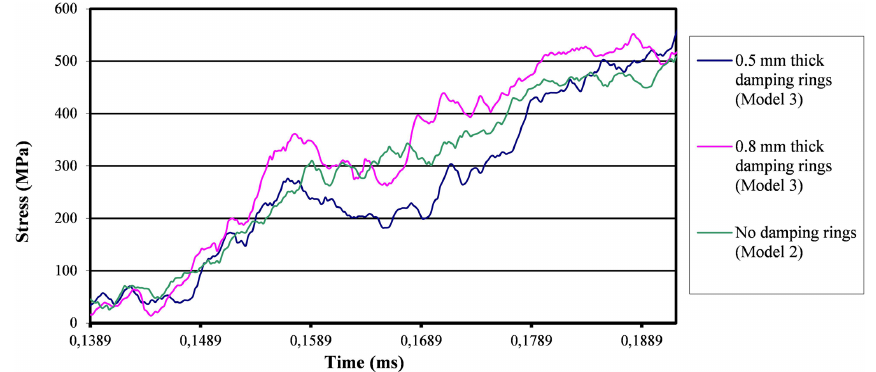
Figure 35. Stress-time curves pertinent to the actual experiment at 3.5bar when using 0.8mm thick, 0.5mm thick, and no damping rings.